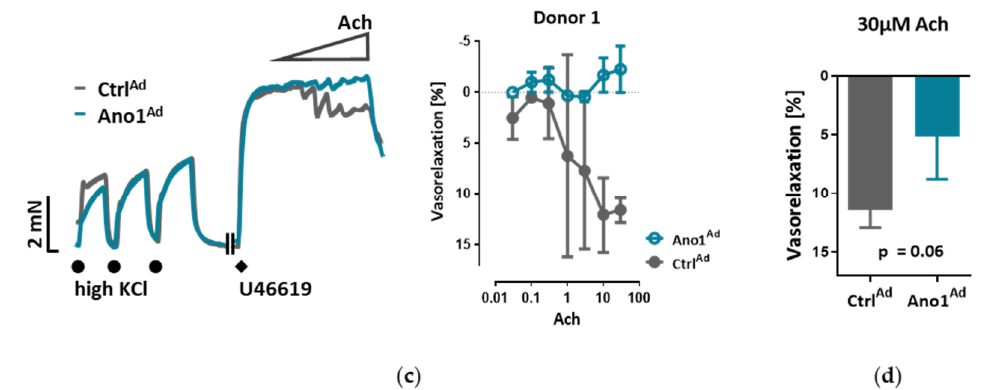
Figure 9. Enhanced TMEM16A results in reduced ACh-induced vasorelaxation of human donor pulmonary arteries. ( a ) Western blot of healthy donor pulmonary artery infected with either Ctrl Ad or Ano1 Ad with quantification of TMEM16A overexpression (right). ( b ) Immunofluorescence staining of donor 3D, precision-cut lung slices (PCLSs) infected either with Ctrl Ad or Ano1 Ad (scale bar = Width = 1257.93 μm, Height = 1257.93 μm, Depth = 82.00 μm for Ctrl Ad and 247.00 μm for Ano1 Ad ). ( c ) Representative isometric tension measurements showing ACh-mediated vasorelaxation of U46619 pre-constricted donor pulmonary arteries (PAs) infected with either Ctrl Ad or Ano1 Ad (left) and quantification of the results (right) showing 2–3 PAs from the same donor in both groups. ( d ) The effect of TMEM16A overexpression on 30 μM ACh-induced vasorelaxation of 300 nM U46619 preconstricted healthy donor pulmonary arteries. Figure was generated with 7 pairs of vessels taken from N=3 donors. Unpaired t-test.